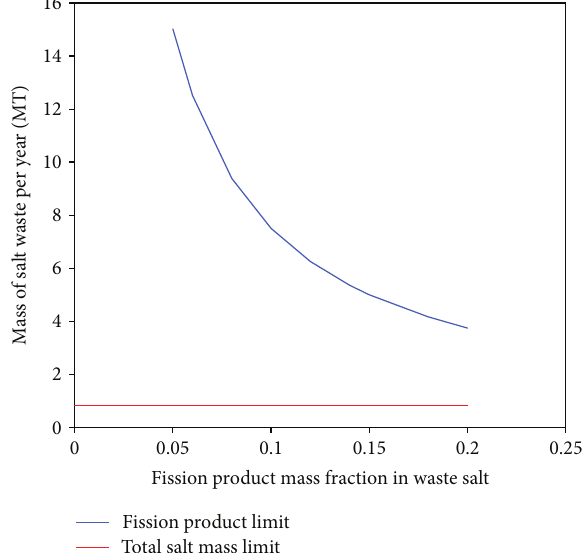
Figure 5: Estimated OR salt waste mass per year for a 100MTHM/ year pyroprocessing facility considering cases where the OR is fission product limited or total salt mass limited and only salt throw- away is pursued.